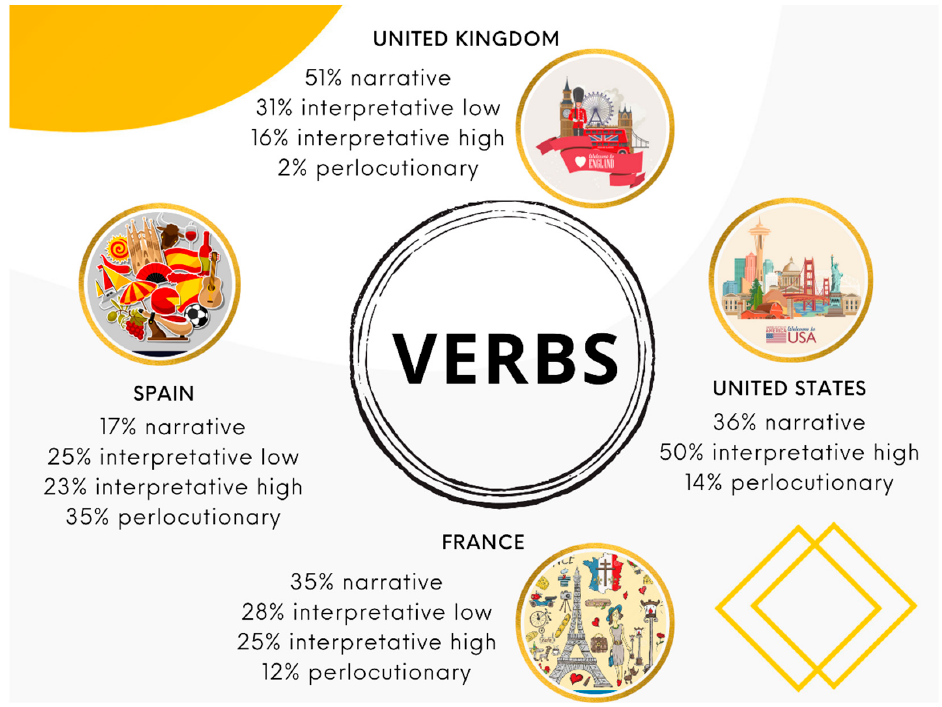
Figure 8. Analysis of COVID-19 ′ s verbs.